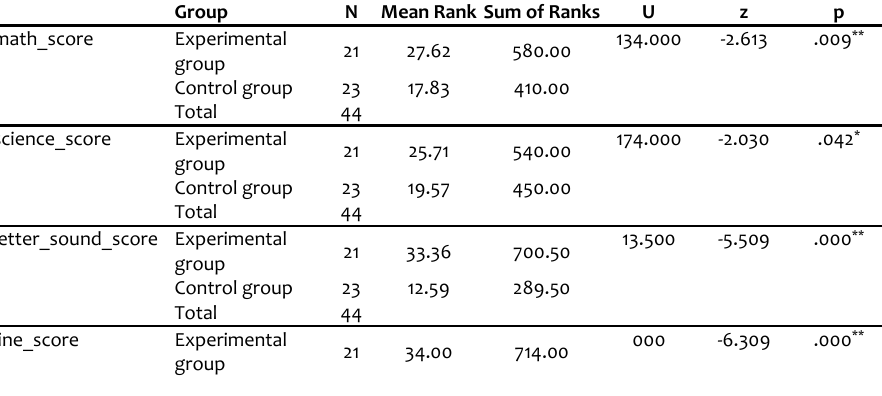
Table 7. Post-test results of the practice scores in the Experimental and Control groups